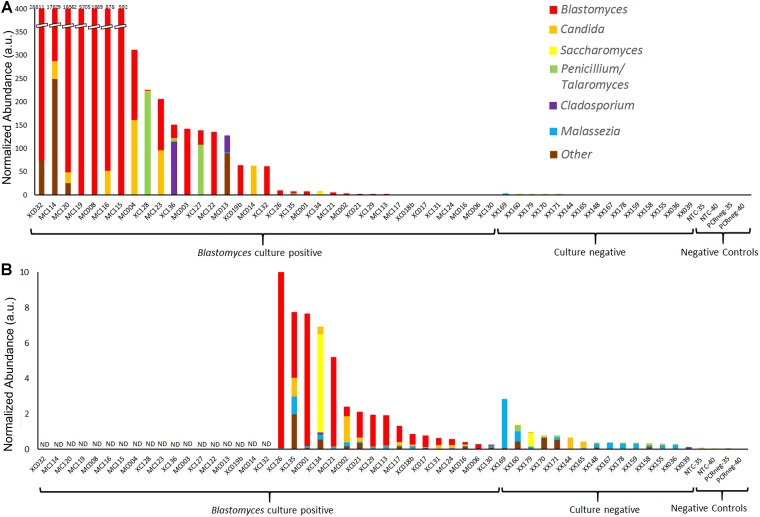
Normalized abundance of fungal taxa detected by ITS1 mycobiome analysis of BAL specimens and negative controls following ITS abundance normalization. Values are expressed as arbitrary units (a.u.) (A) Normalized abundance of all Blastomyces-culture-positive and culture-negative BAL specimens and negative controls with (B) showing an enlarged graph of samples with a total normalized abundance of ≤10 a.u. ND, data not displayed.